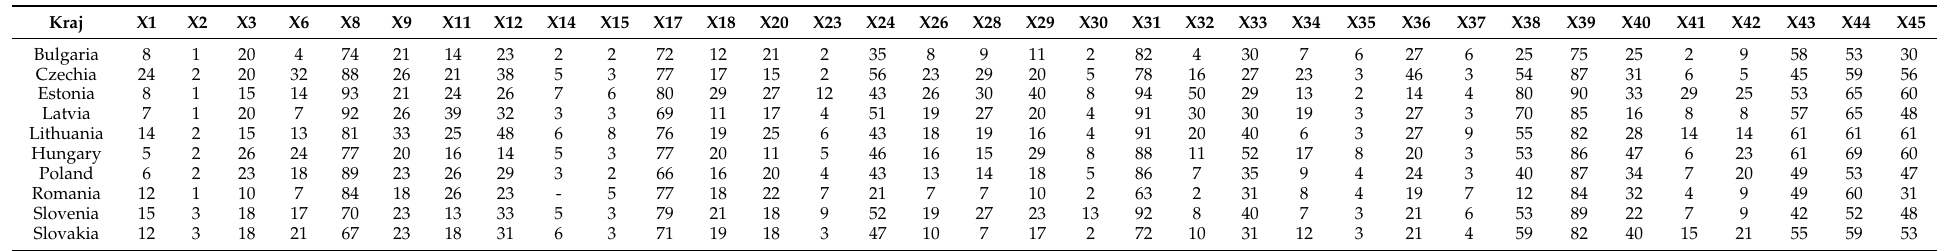
Table 1. Diagnostic variables in platformization study of the CEE countries after verification * in